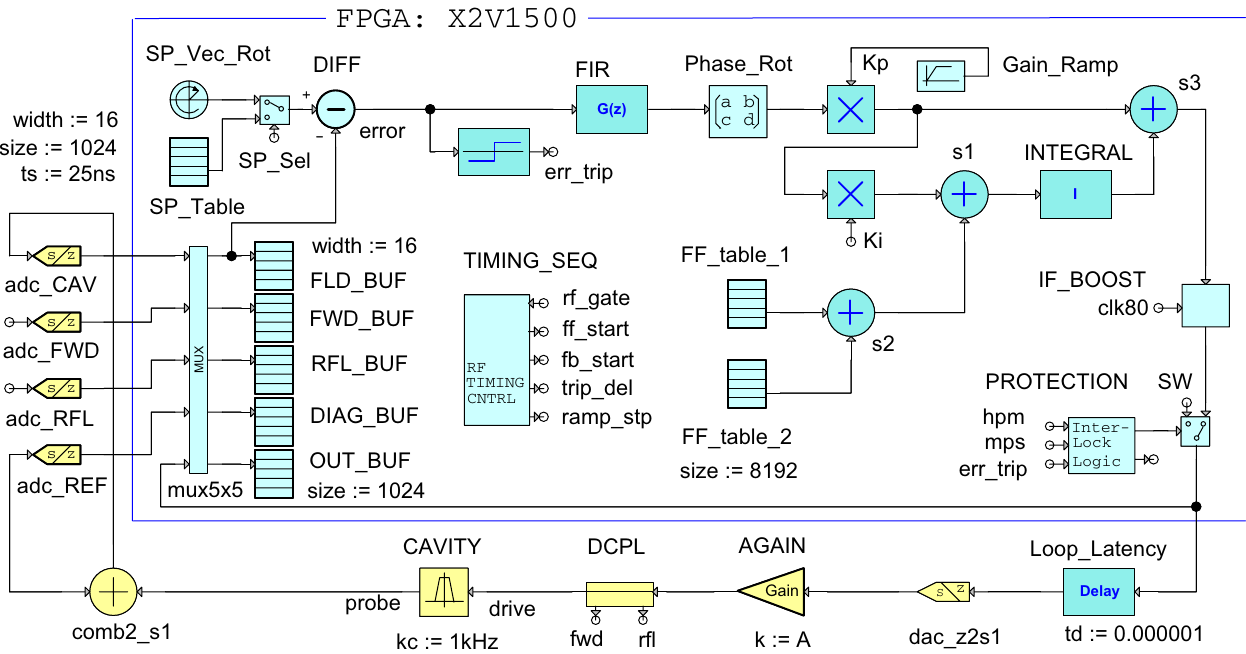
FIG. 3. (Color) A model of SNS rf control system. All required control functionalities in the blue box are implemented in one FPGA